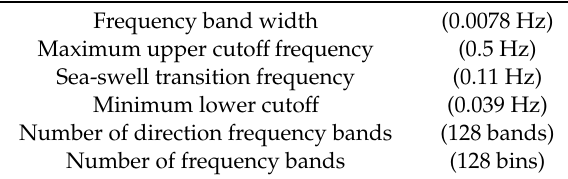
Table 7. The spectral analysis parameters of the